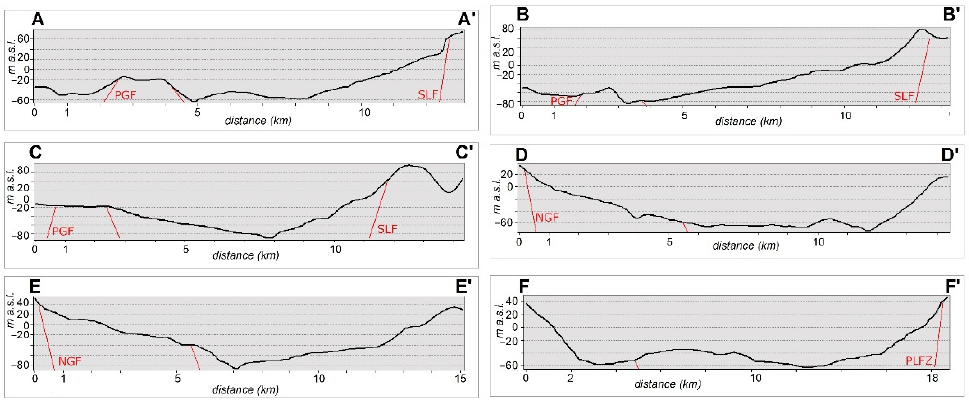
Figure 4. Transversal ( AA’ , BB’ and CC’ ) and longitudinal ( DD’ , EE’ and FF’ ) profiles of the HU2 top (see Figure 3a for profile location).